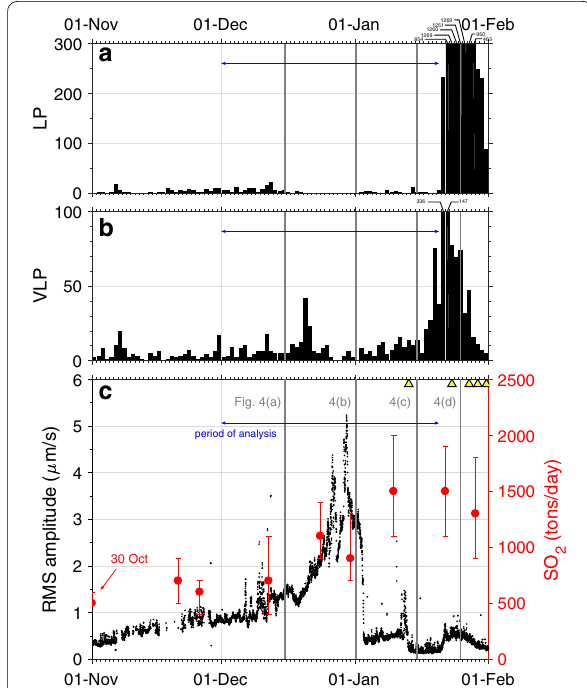
Fig. 3 Seismicity and amplitude variation of volcanic tremors. a , b Daily numbers of LP and VLP events at Aso volcano for a three-month observation period reported by Japan Meteorological Agency (2014). c Change in the root-mean-squared amplitude of the seismic record at SUN (black dots) and SO 2 discharge rate measured by Japan Meteorological Agency (2014) (red circles). The yellow triangles at the top of the diagram represent reported eruptions. Four vertical gray lines that run through (a–c) indicate the times of the graphs shown in Fig. 4. Blue horizontal arrows indicate the time span of our